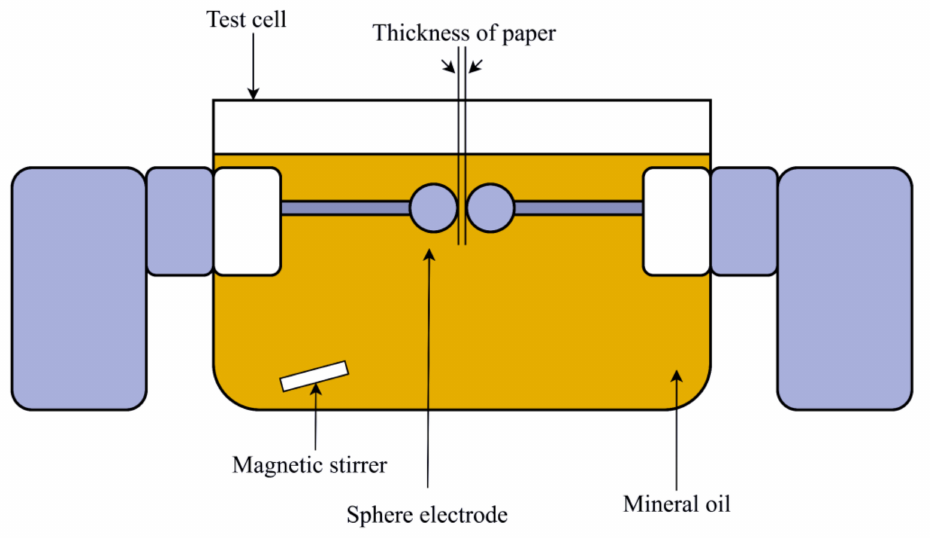
Figure 9. AC breakdown voltage test of